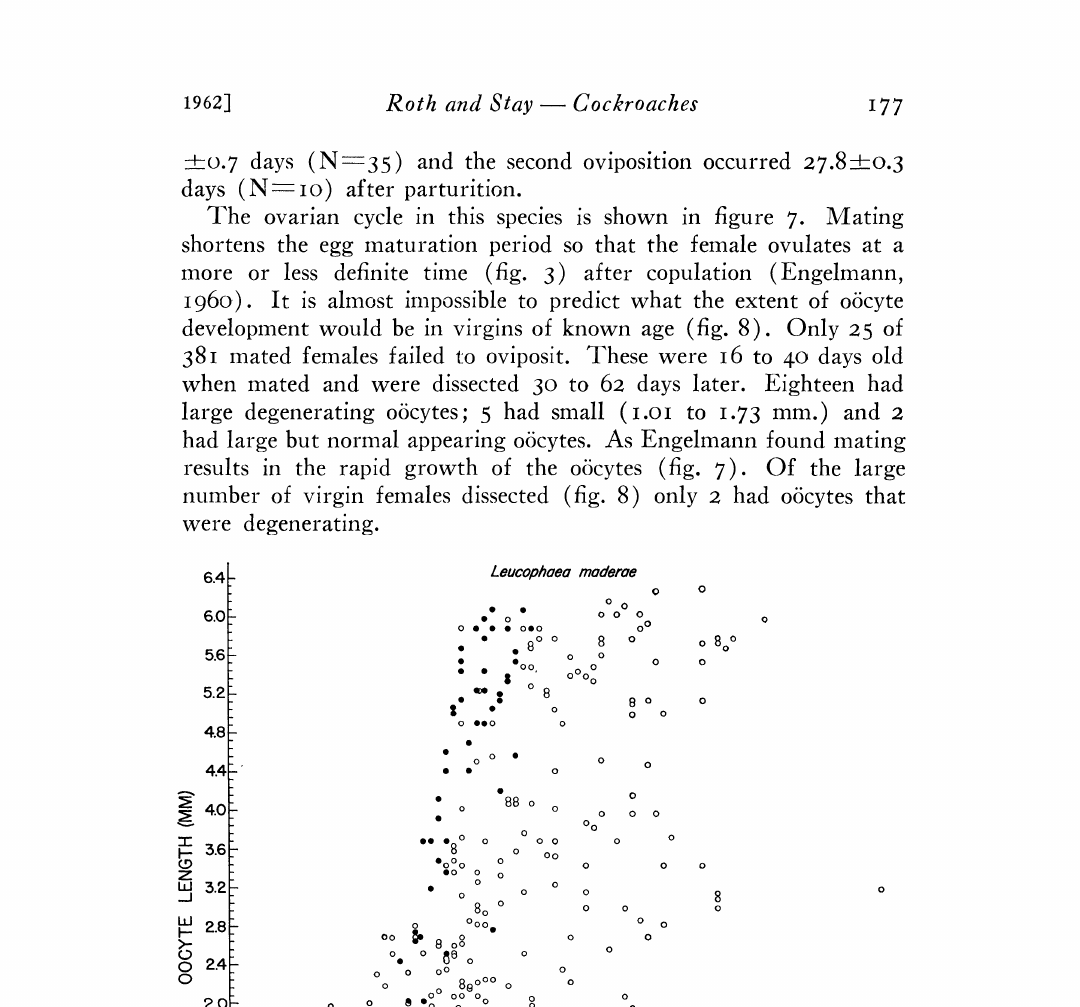
Oocytes, virgin females Oocytes, mated